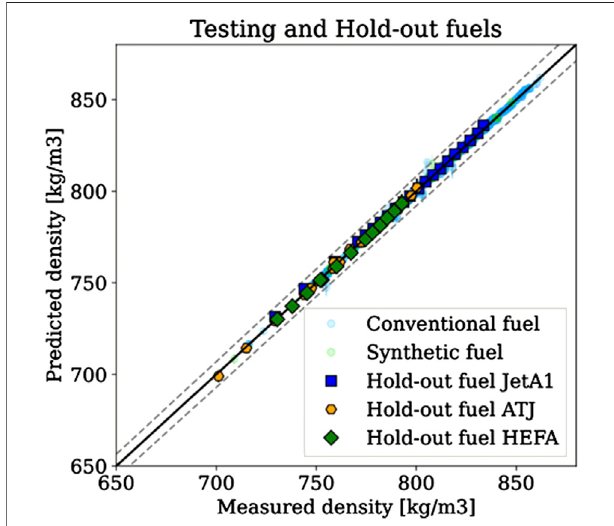
FIGURE 6 | Unity plot displaying the predictive capability of machine learning models for synthetic fuels compared with data from the fuels database (Hall et al.,